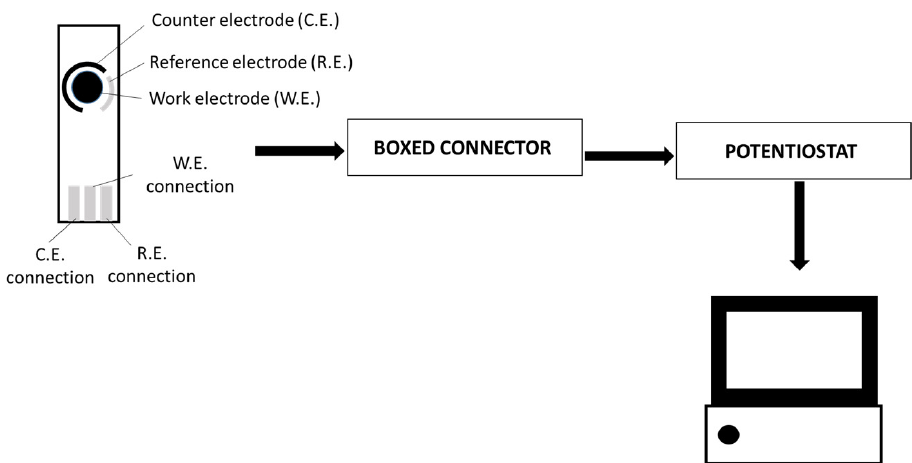
Figure 1. Cyclic voltammetry experimental set-up.